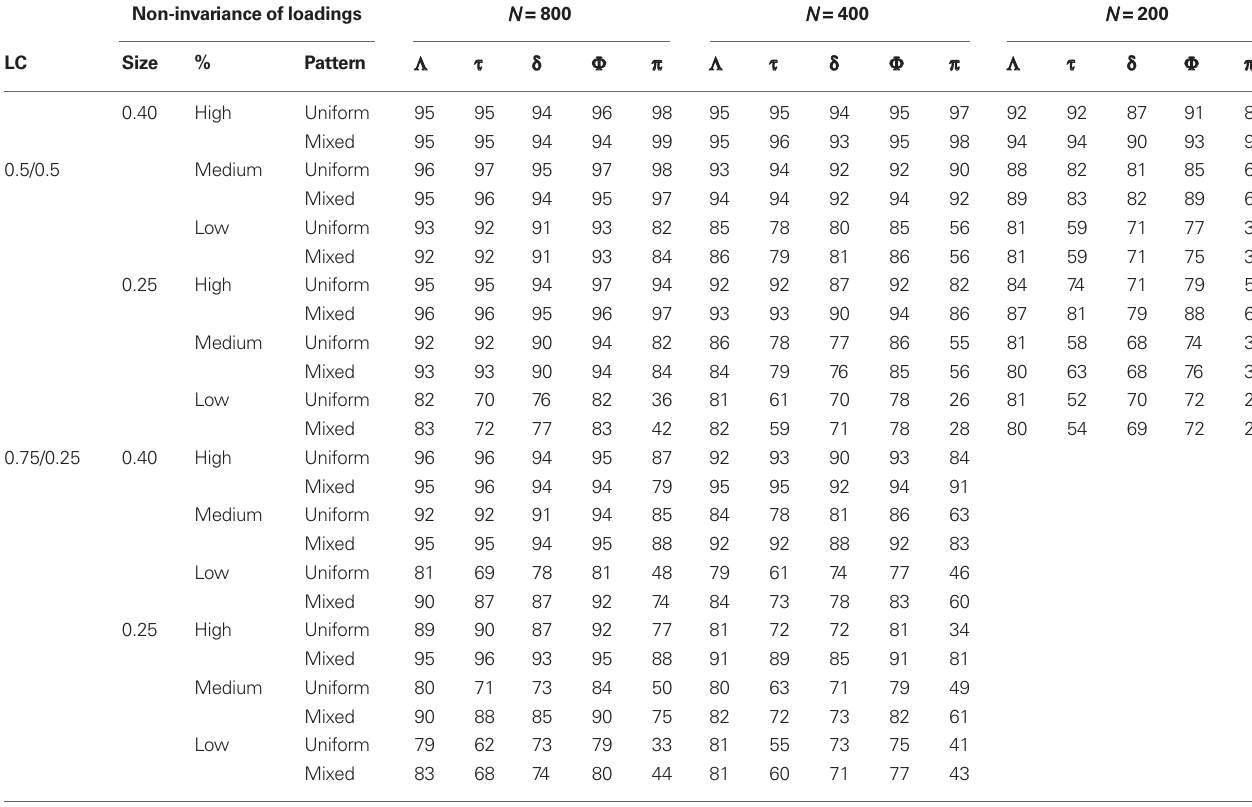
Table 3 | Percentage of replications out of 500 in which 95% confidence interval covers parameter ( Λ , factor loading; τ , measurement intercept; δ , error variance, Φ , factor variance, π , latent class